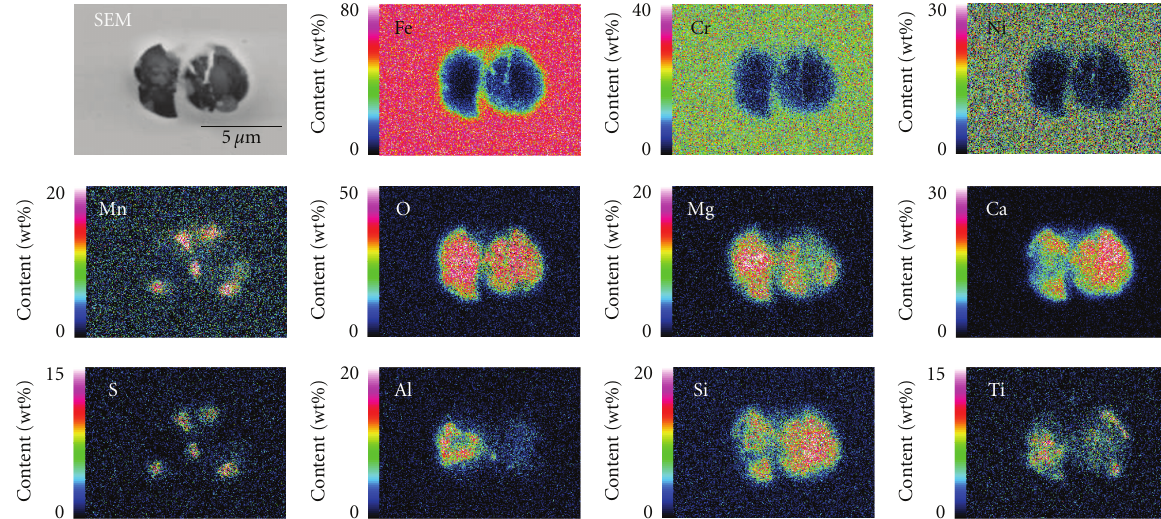
Figure 2: SEM image and EDS elemental mappings for as-polished commercial Type 316L stainless steel.